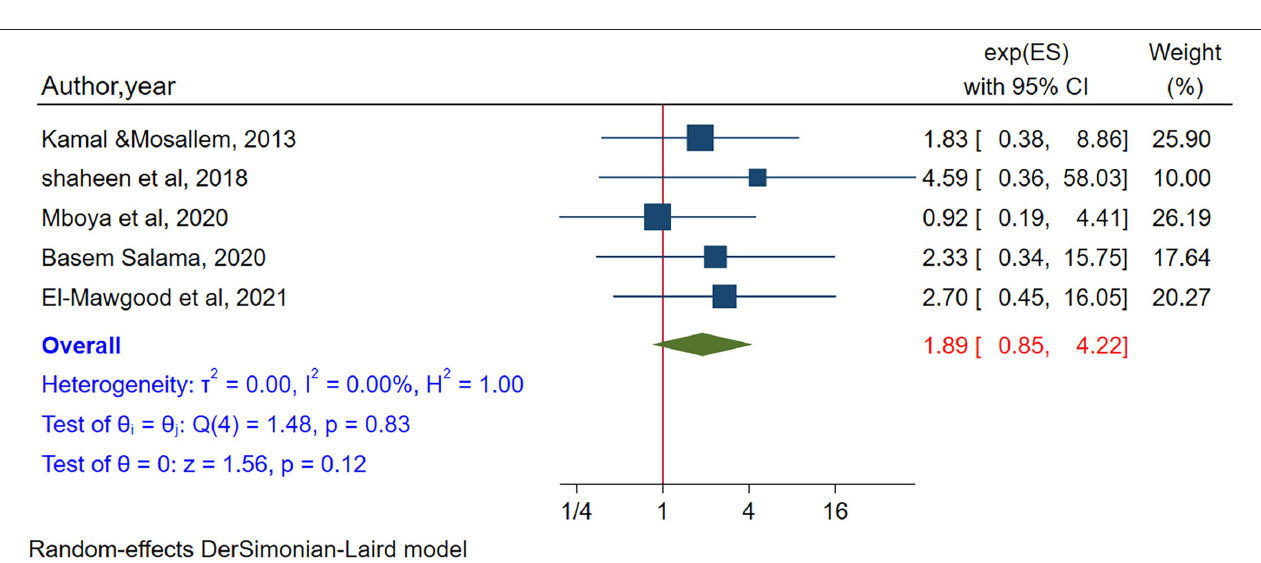
FIGURE 5 | The pooled association between availability of internet at home and internet